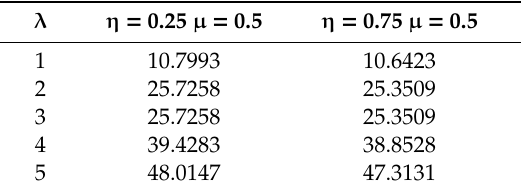
First five natural frequencies for the UD distribution for two di ff erent states of partial